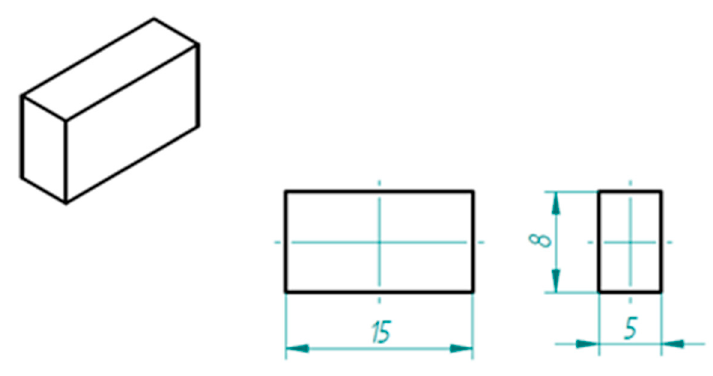
Figure 4. The specimen (please note dimensions are in mm).